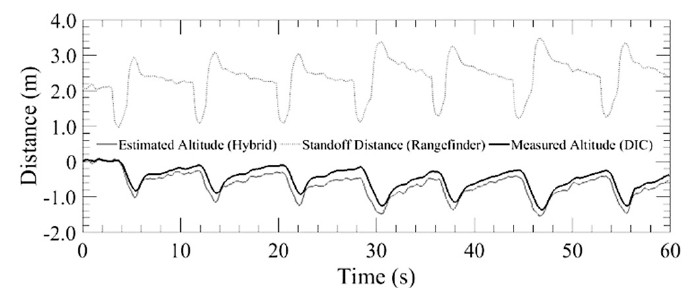
Figure 19. Standoff distance v. aircraft altitude for overhead obstacle avoidance test.